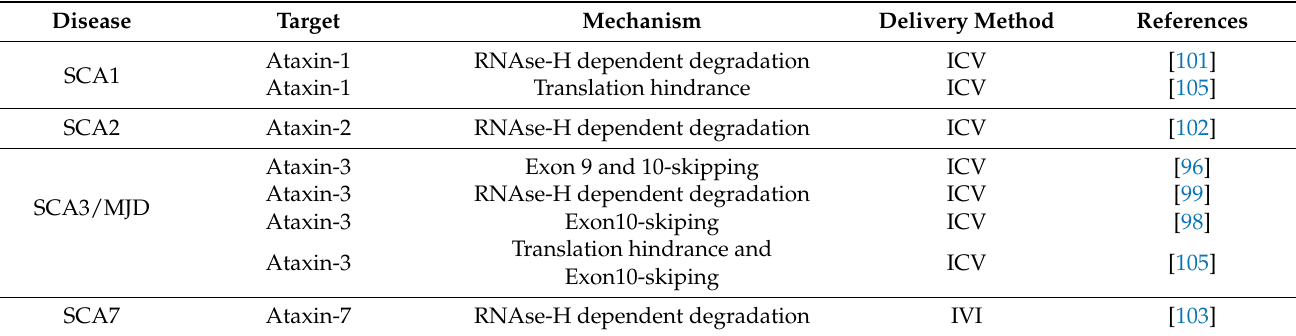
Table 6. Selected ASOs-based studies in polyglutamine spinocerebellar ataxias.